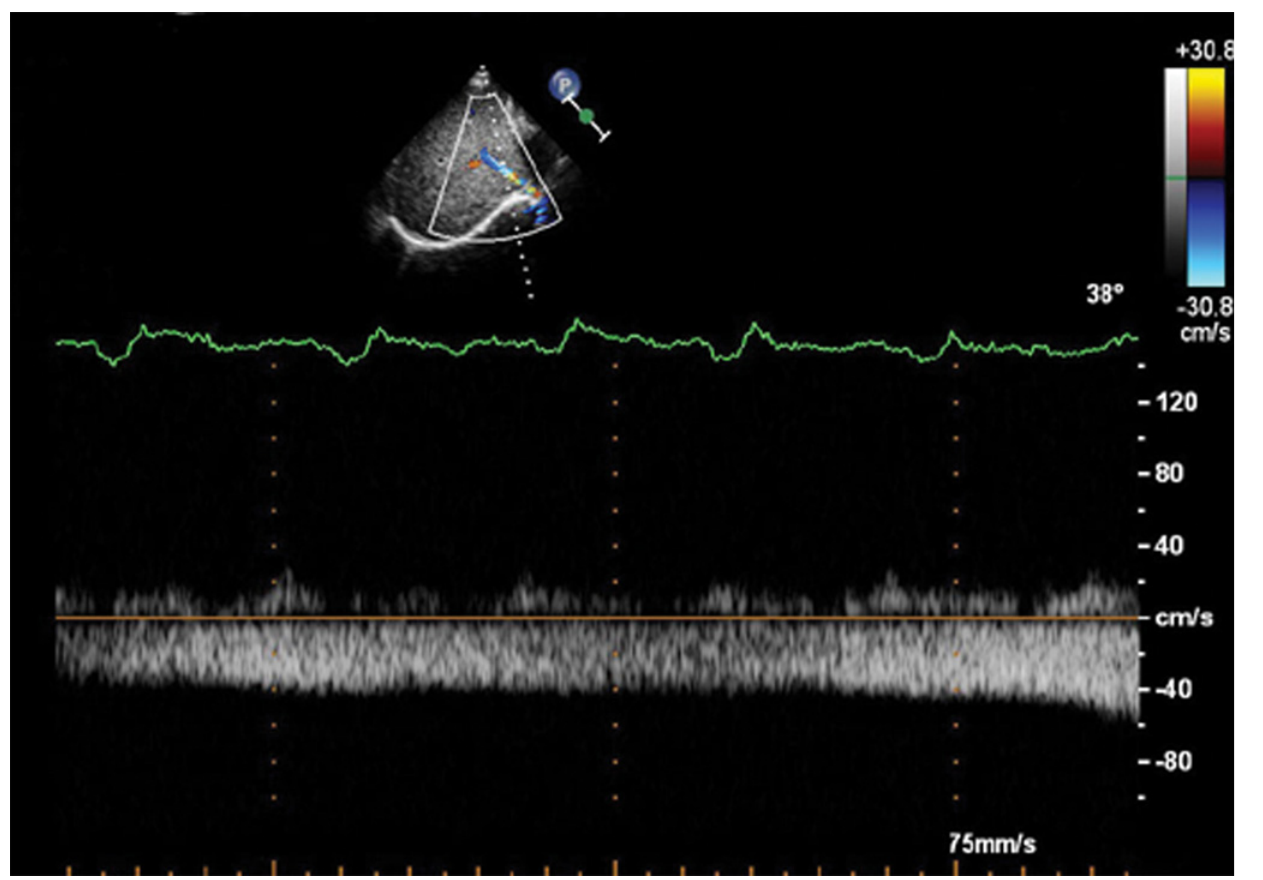
Fig 4. Mono-phasic Doppler flow spectra of the MHV in the PH group. Doppler spectra of MHV obtained from a patient with atrial septal defect with the MPAP of 33 mmHg. The waveform of MHV is flat and